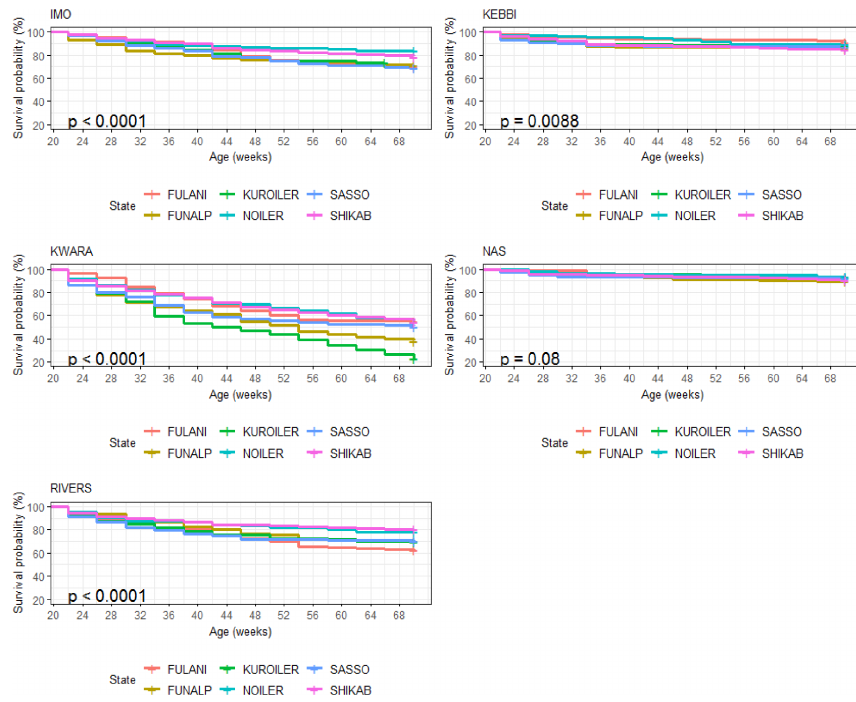
Figure 18. Breed by environment interaction on survivability of female birds (agroecologies) raised on-farm in ACGG Nigeria project zones (20–72 weeks) (2016–2018).